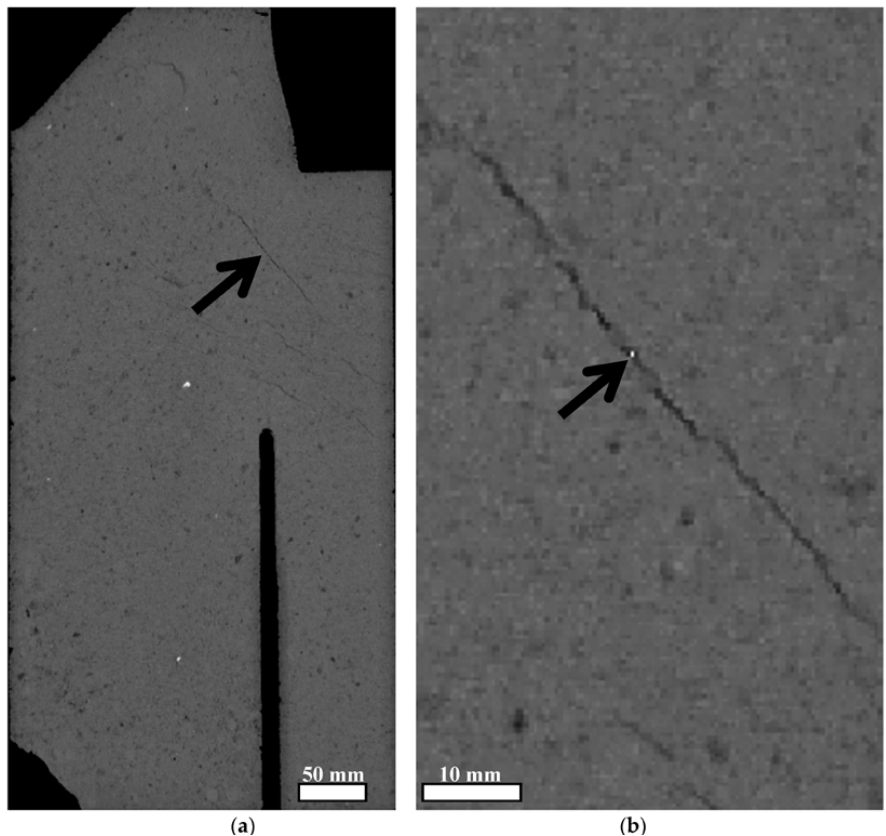
Figure 12. 2D view of the crack (top right) used to test the 3D percolation algorithm on thick anode slice: ( a ) full view; ( b ) zoom on the cracked zone investigated with the seed voxel (white dot identified with a black arrow). Metals 2016 , 6 , 272